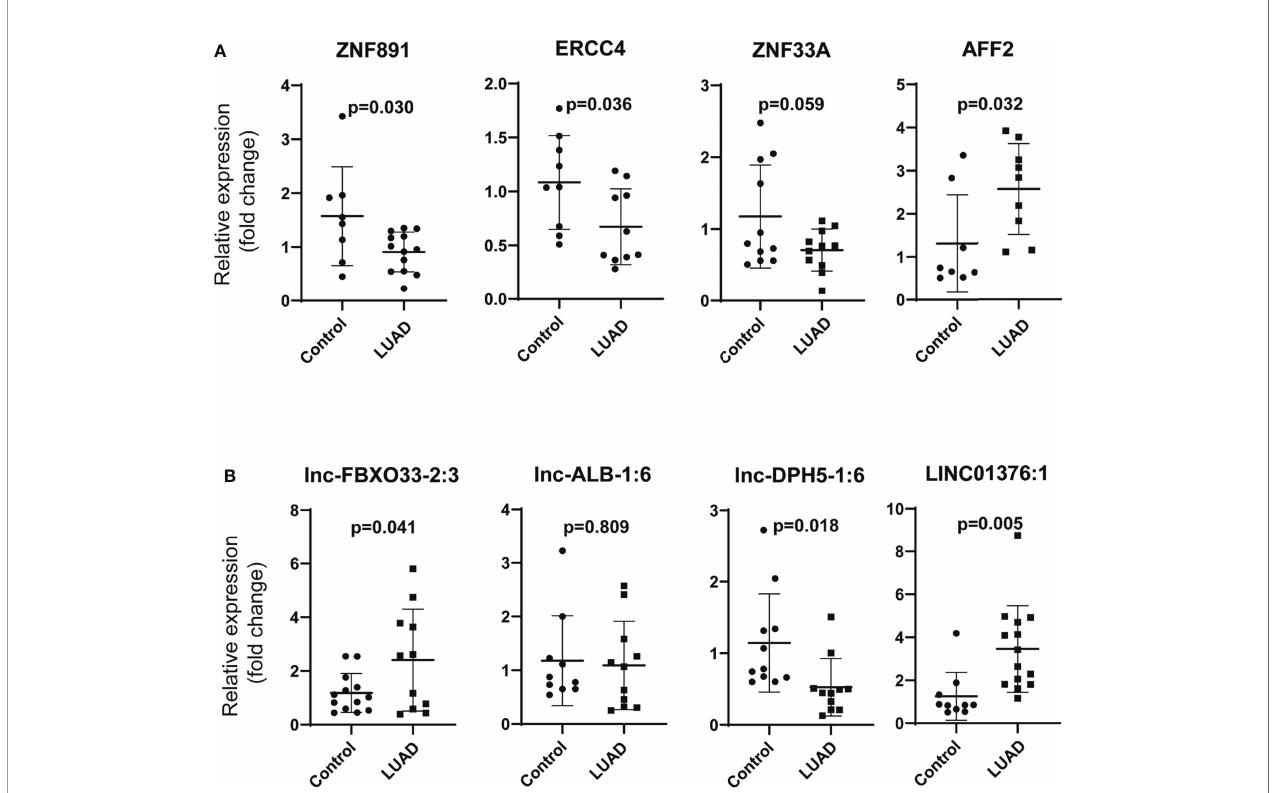
FIGURE 7 | Validation of the differentially expressed mRNAs and lncRNAs in LUAD. (A) Validation of the differentially mRNAs (ZNF891, ERCC4, ZNF33A, and AFF2), (B) validation of the differentially lncRNAs (lnc-FBXO33-2:3, lnc-ALB-1:6, lnc-DPH5-1:6, and LINC01376:1) (LUAD, lung adenocarcinoma; ZNF891, zinc fi nger protein 891; ERCC4, excision repair cross-complementation group 4; ZNF33A, zinc fi nger protein 33A; AFF2, AF4/FMR2 family, member 2; relative fold change of each sample was calculated using the mean GAPDH expression of control group as